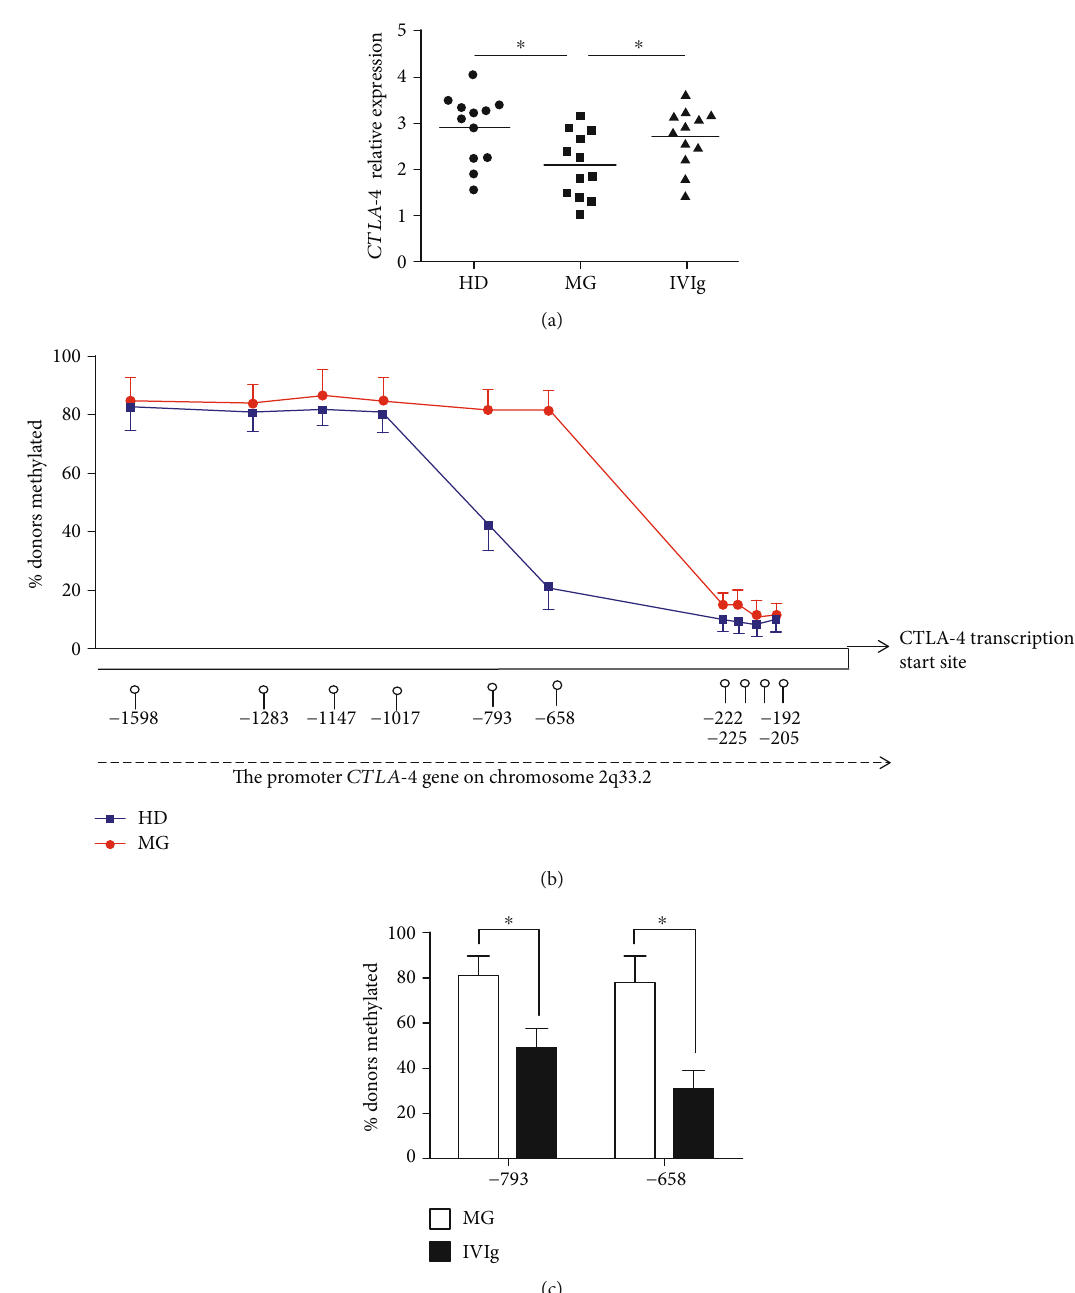
Figure 5: Quantitative analysis of CTLA-4 mRNA in Treg cells from myasthenia gravis patients (MG) and healthy donors (HD). (a) Total RNA was extracted from sorted Treg cells of MG and HD and then real-time PCR was performed to measure CTLA-4 mRNA level. (b) Genomic DNA was prepared from sorted Treg cells and methylation status within CTLA-4 promoter was detected. The methylation percentage within CTLA-4 promoter in Treg cells from HD and MG ( n = 10 ) was shown. (c) The methylation percentage at -658 and -793 CpGs in Treg cells from MG and MG with IVIg therapy ( n = 12 ) is shown. Data are expressed as mean ± SD . ∗ P < 0 : 05